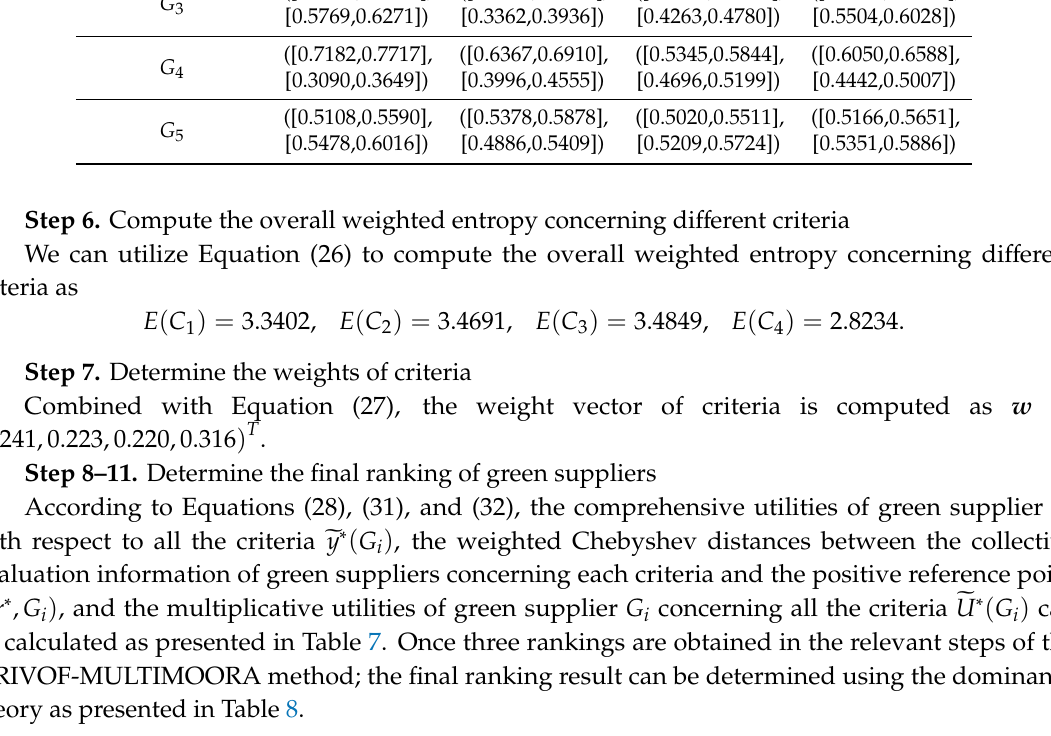
Table 7. Ranking indexes of the q-rung interval-valued orthopair fuzzy multi-objective